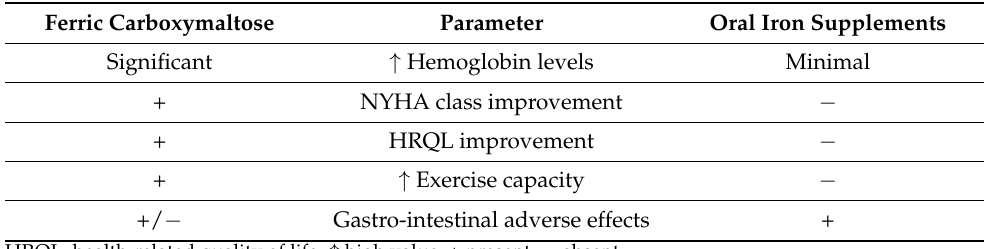
Table 3. Comparison of the efficacy and side effects of ferric carboxymaltose versus oral iron